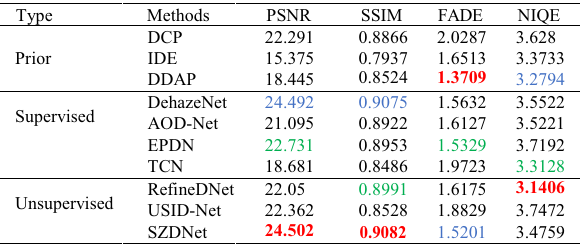
Fig. 5 Comparison of atmospheric light estimation with SOTA methods. a Hazy images. b – d Brightest sky regions (marked by red rectangles) obtained using the method reported by ( b ) Li et al. [19], ( c ) Wang et al. [26], and ( d ) proposed method Table 1 Quantitative comparison between SZDNet and SOTA meth- ods on the SOTS dataset. The best, second best, and third best perfor- mances are marked in red, blue, and green, respectively